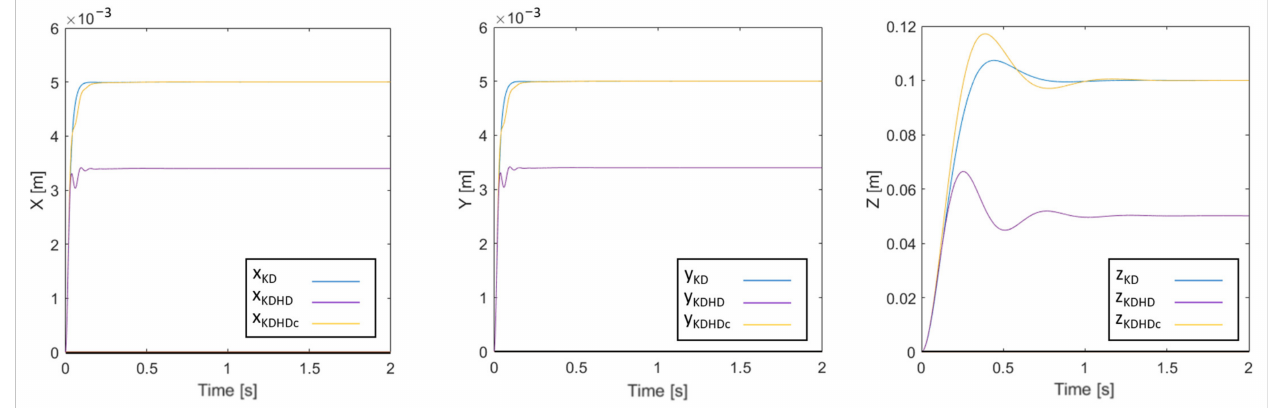
Figure 8. Case study B, KD-KDHD comparison number II, external coordinates.